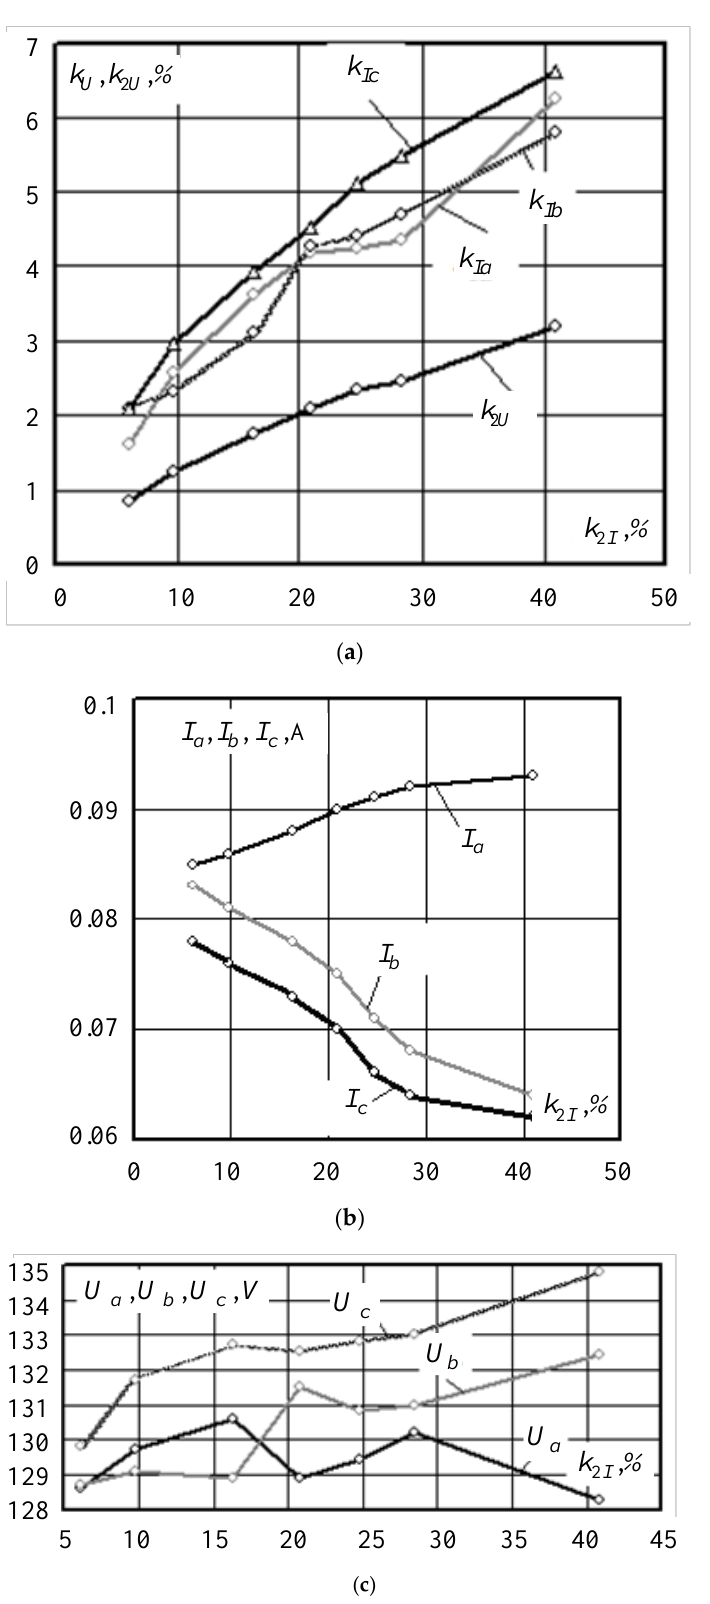
Figure 7. Generator load flow as a function of the current unbalance ratio k